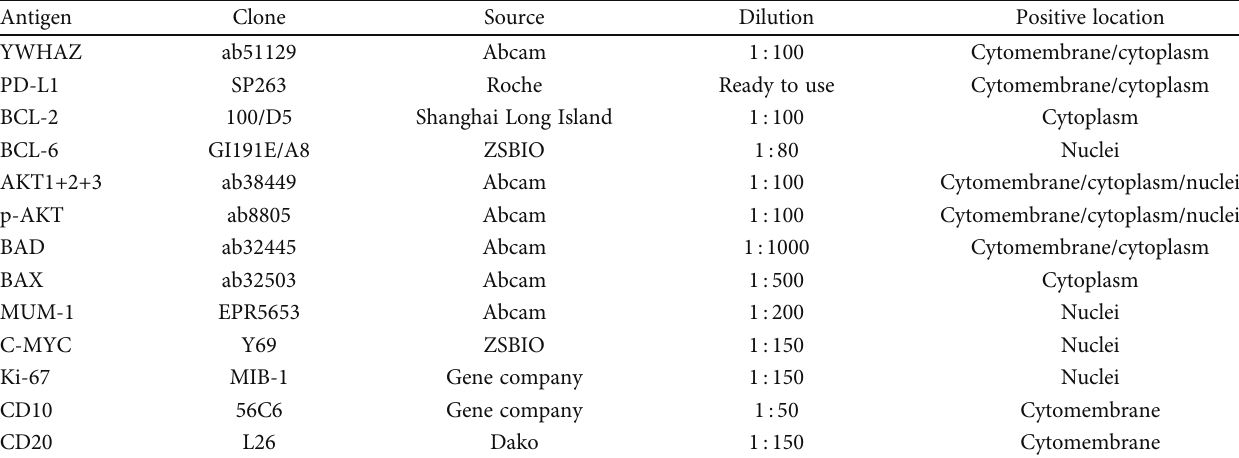
Table 1: Primary antibodies and conditions used for immunohistochemical